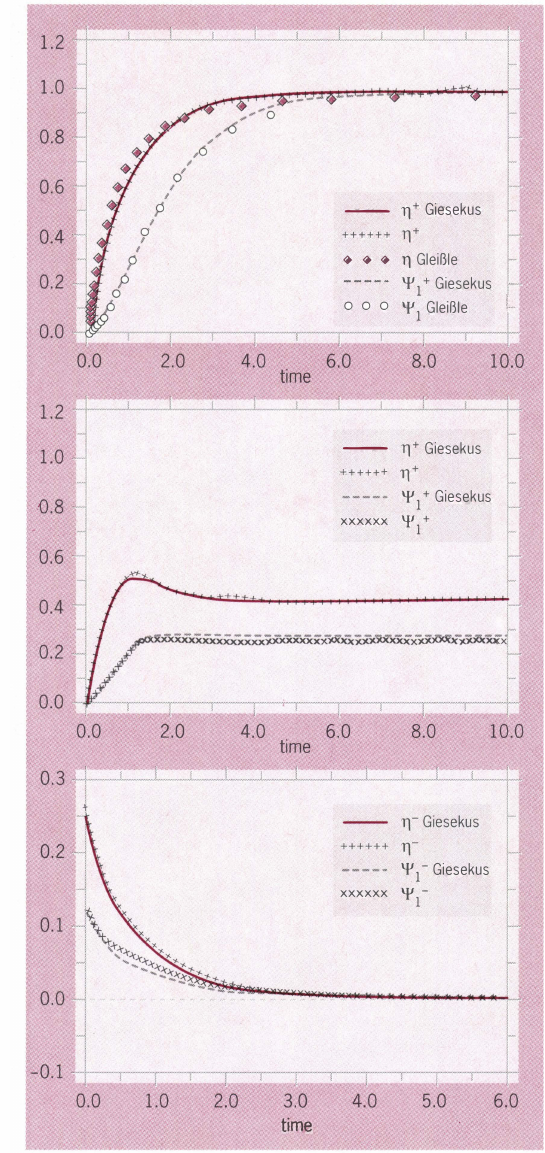
Fig. la-c: a.} Linear start-up flow properties of CTAB-NaSal 60-350 and the result of both Gleillle relationships. b.} Nonlinear start-up flow properties and c.} nonlinear cessation of flow properties of CPyCI-NaSal 100-250 compared to the Giesekus